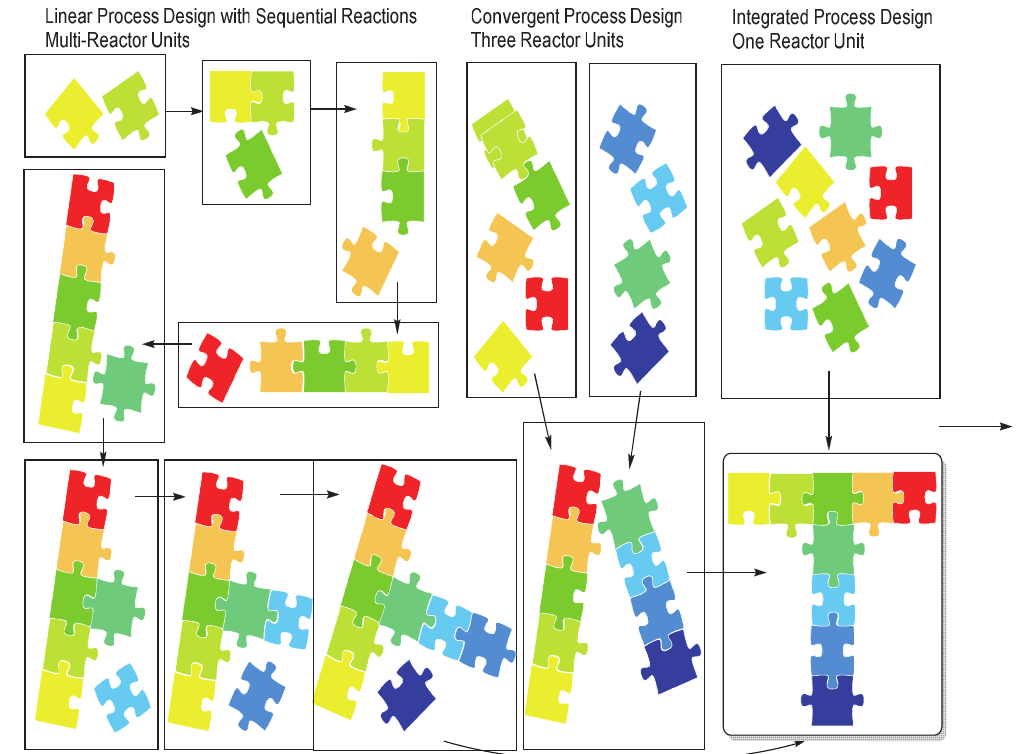
Fig. 5 – Bioinspired biocatalytic process design